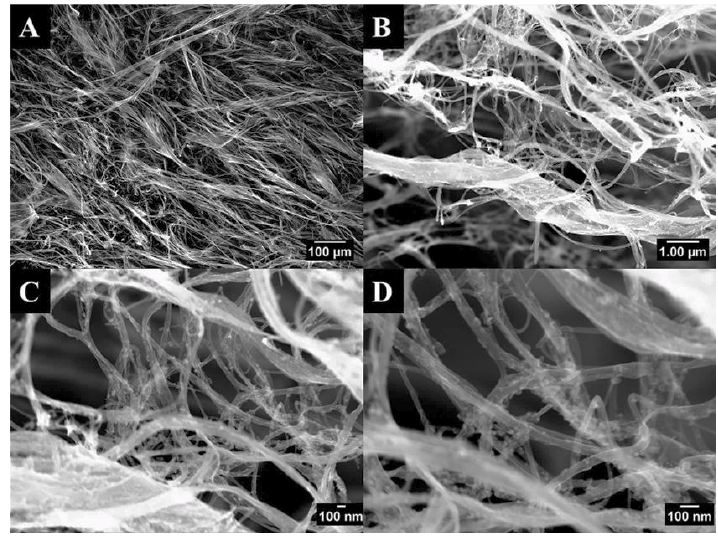
Figure 4. SEM images of the as received CNTs at varying magnifications ( a ) 100×, ( b ) 10000×, ( c ) 25000×, and ( d ) 55000×.